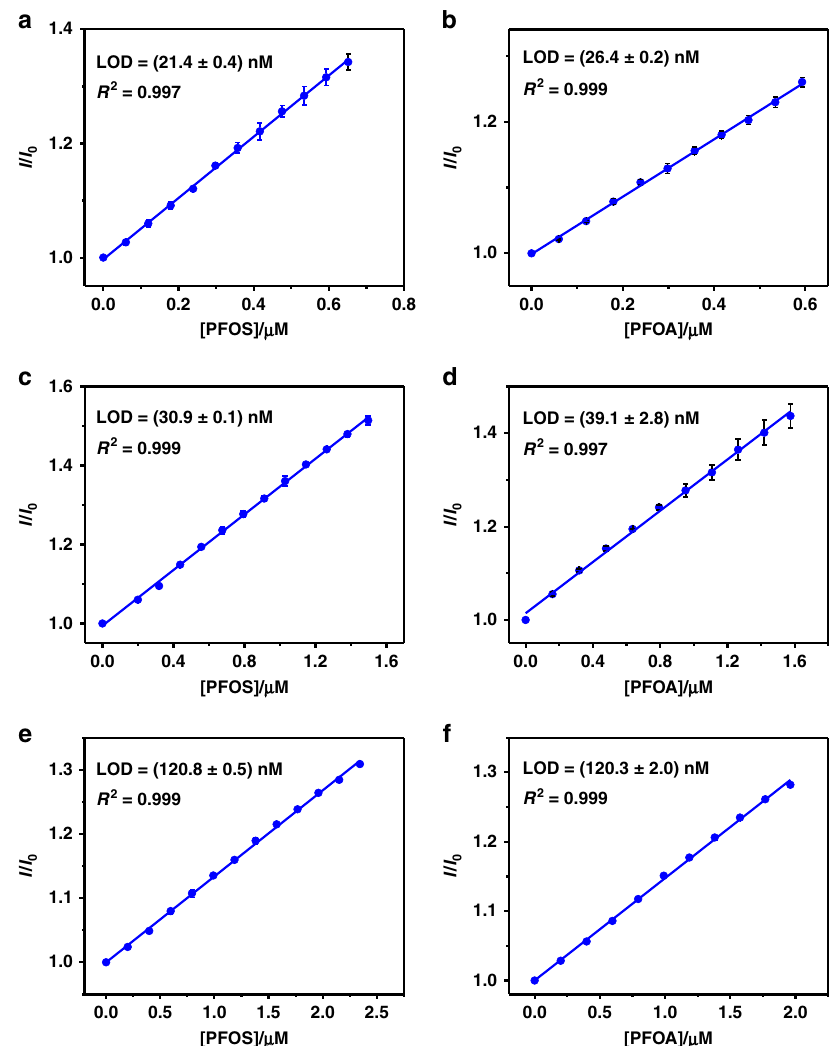
Fig. 4 Calibration curves and LOD values of PFOS and PFOA in different media. Plots of I / I 0 against PFOS (left) and PFOA (right) concentrations in a , b HEPES buffer, c , d tap water, and e , f water of Mati Lake. I and I 0 are the intensities of fl uorescence of the GC5A-6C (cid:129) Fl (0.8/1.0 μ M for a , b ; 3.0/1.0 μ M for c , d ; and 10.0/1.0 μ M for ( e , f ) reporter pair with and without the guest molecules, respectively. All experiments were performed at 25 °C, λ ex = 500 nm, and λ em = 513 nm. Error bars represent mean ± s.d. ( n = 3 independent